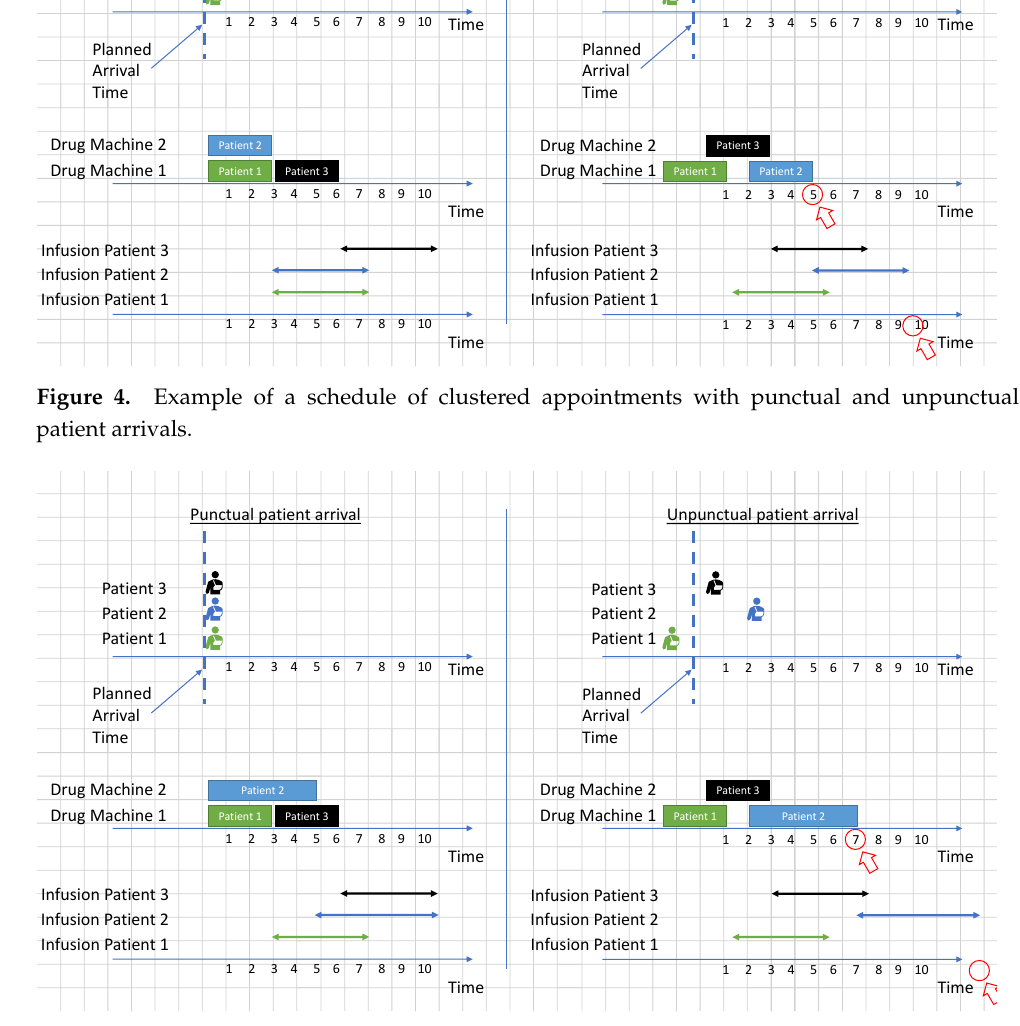
Figure 5. Example of a schedule of non-clustered appointments with punctual and unpunctual patient